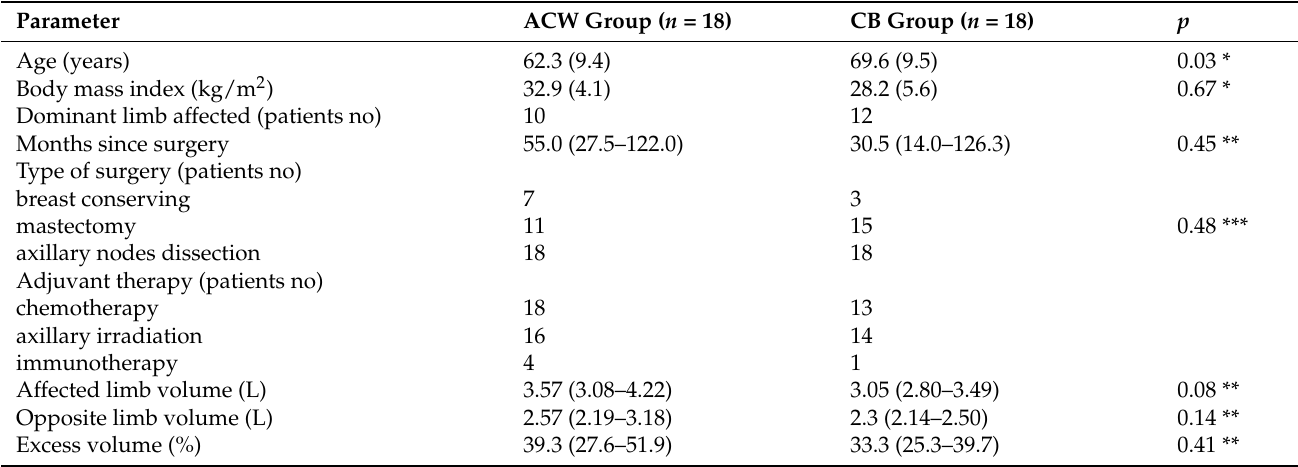
Table 1. Patients